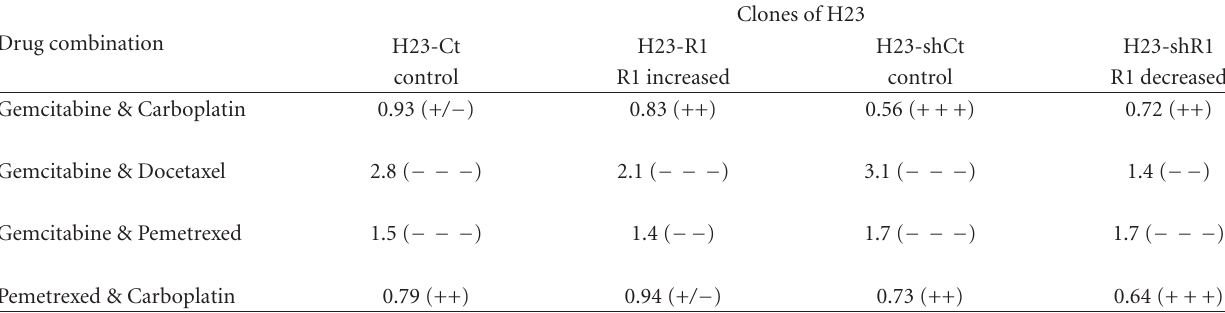
Table 2: Impact of RRM1 expression on drug combinations.